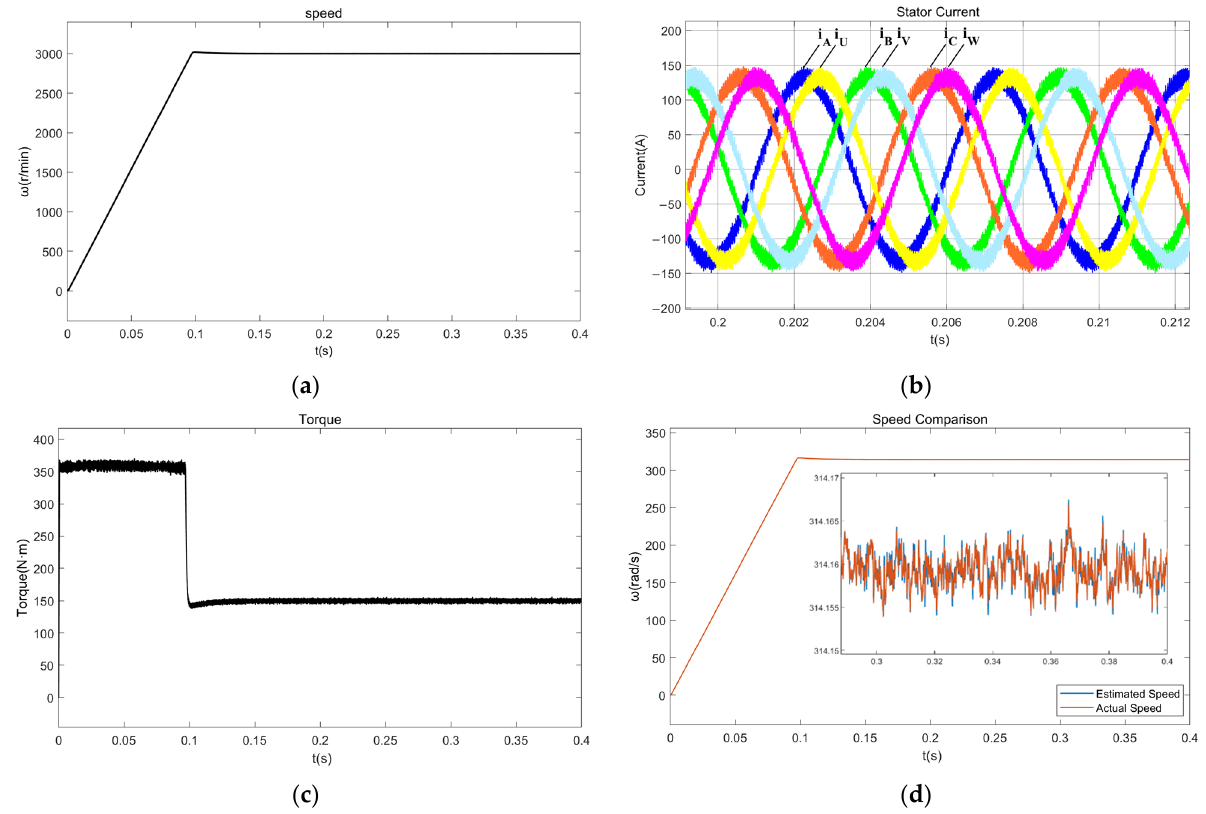
Figure 5. Simulation results in normal mode. ( a ) Speed; ( b ) phase current; ( c ) torque; ( d ) speed comparison.